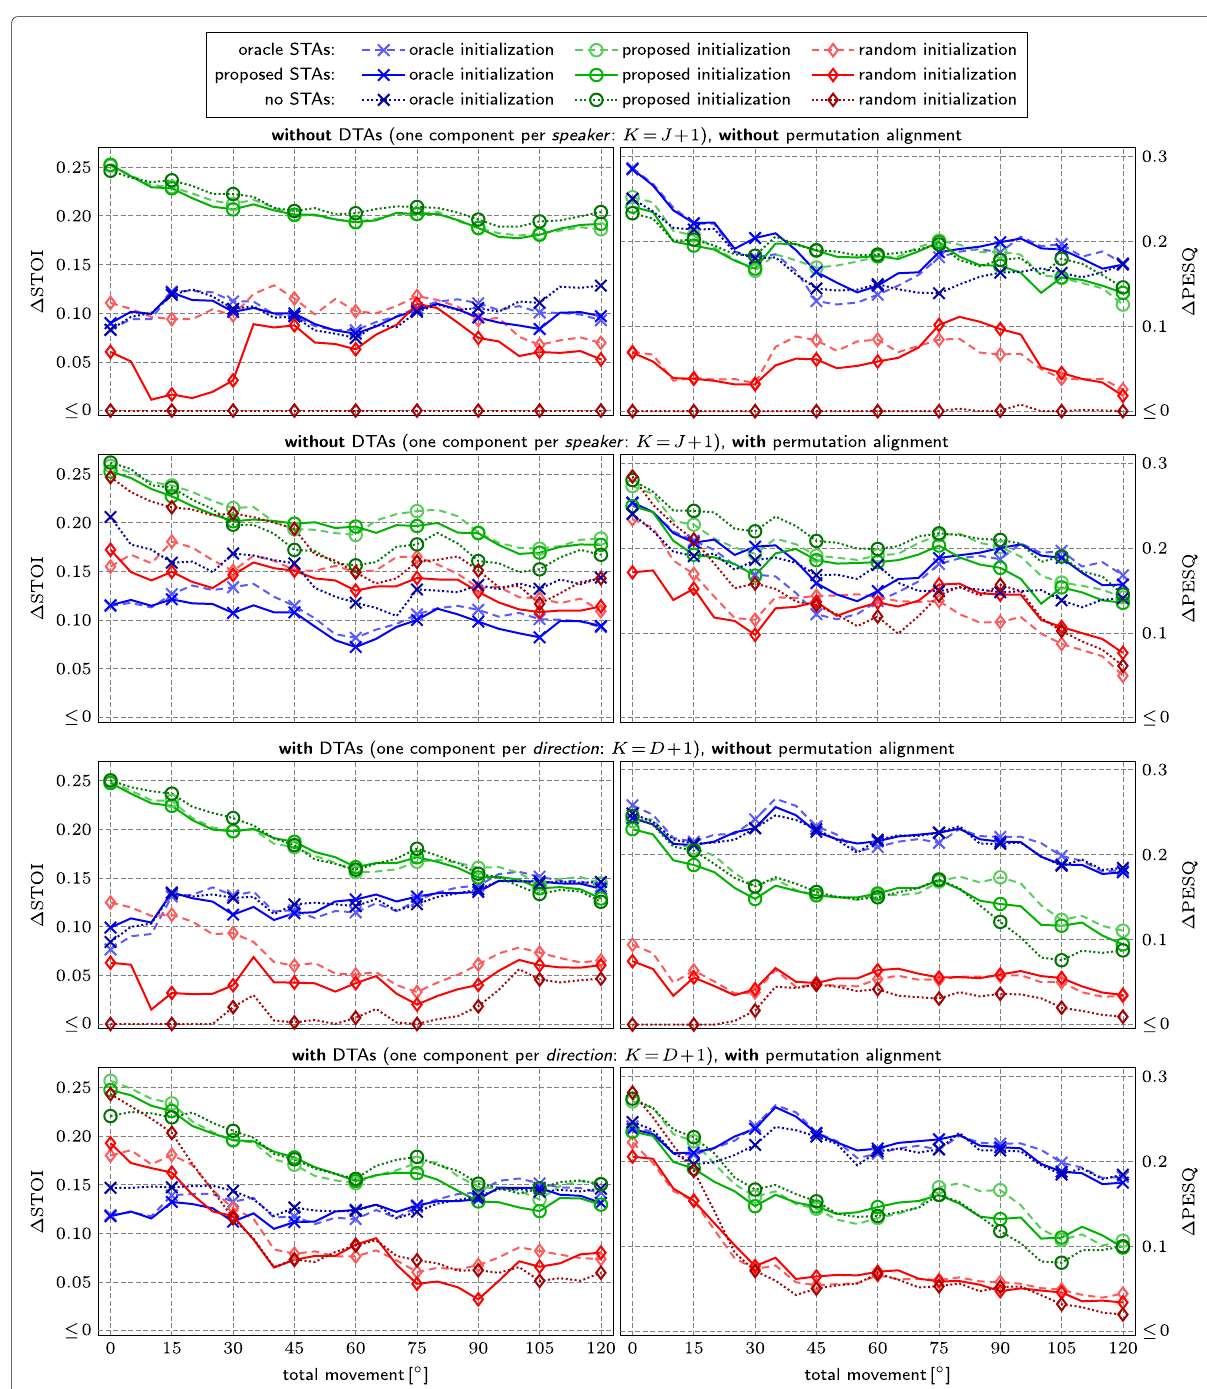
Fig. 11 (cid:15) STOI and (cid:15) PESQ scores for a moving speaker as a function of the total movement over the entire signal duration in terms of the azimuth angle ϕ . To obtain a clearer representation, a moving average was applied (averaging over all results that deviate by up to ± 10 ◦ compared to the values indicated on the x -axis), and negative results were replaced by 0. For this setup, too, the initialization remains the most effective way to benefit from DOA information, rendering time annotations (STAs or DTAs) as well as manual permutation alignment